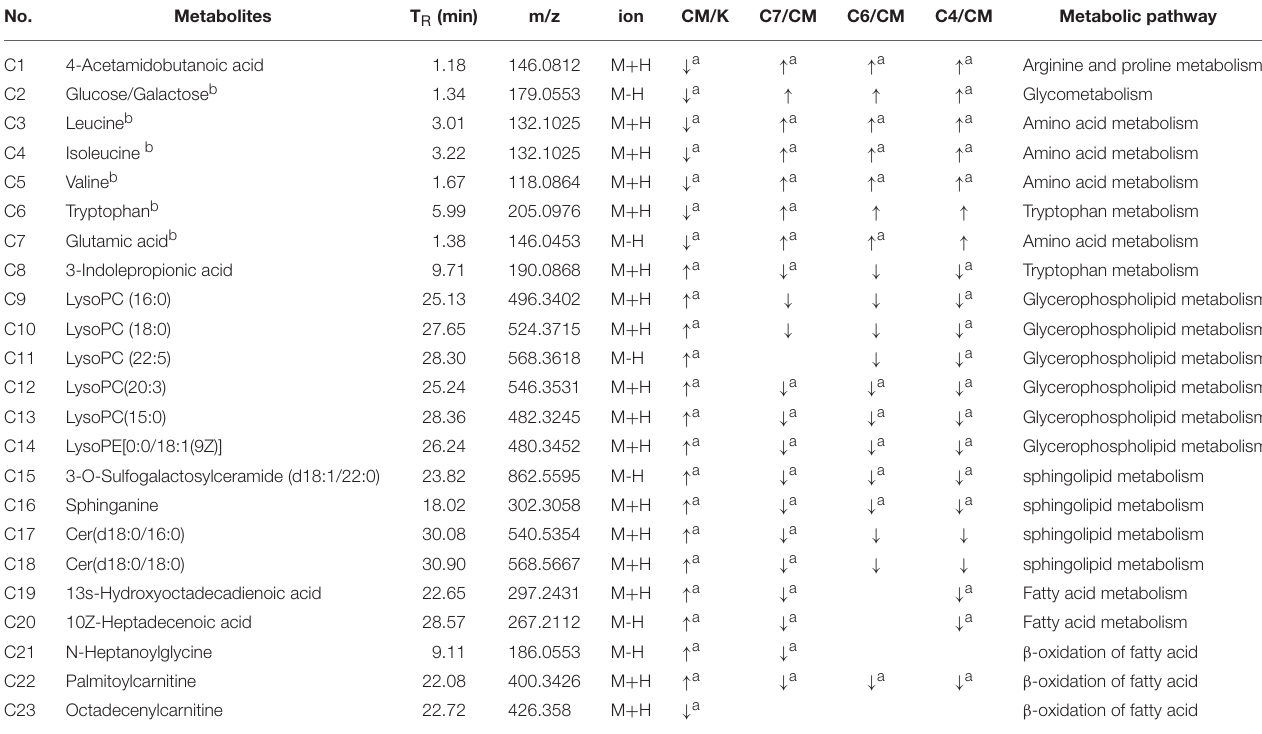
TABLE 1 | Identified differential metabolites in the serum of CUMS rats with or without administration of PBR.